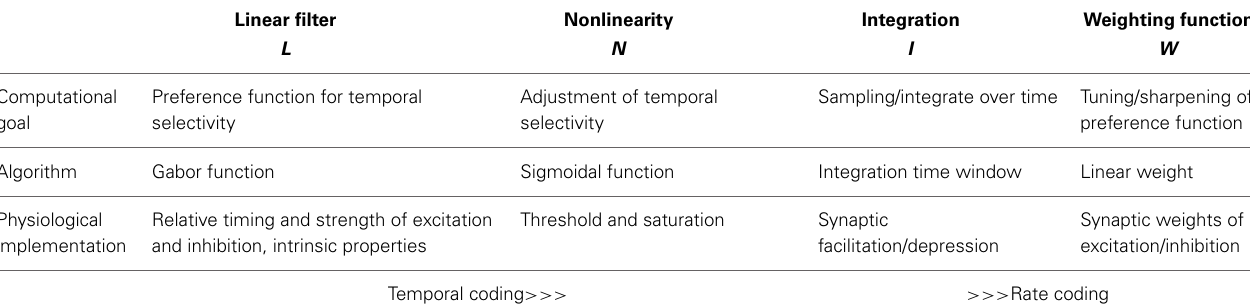
Table 1 | Computational steps for pattern recognition using LN-models: the computational goals, the algorithms of computation and possible physiological